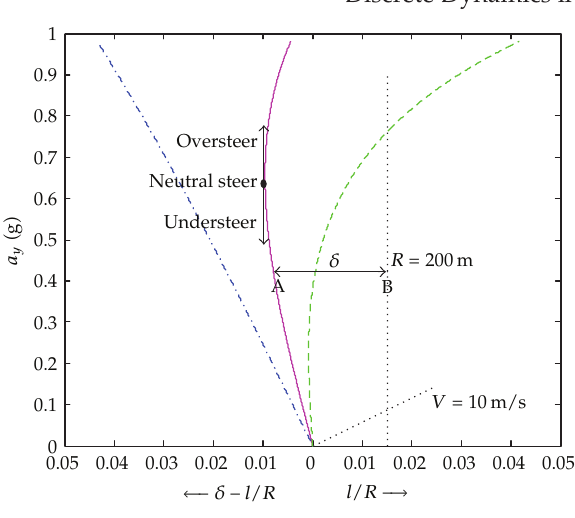
Figure 3: Handling diagram for a passenger car. Table 1: Equivalent definitions for understeer, neutral steer, and oversteer of a complex vehicle. At a constant radius